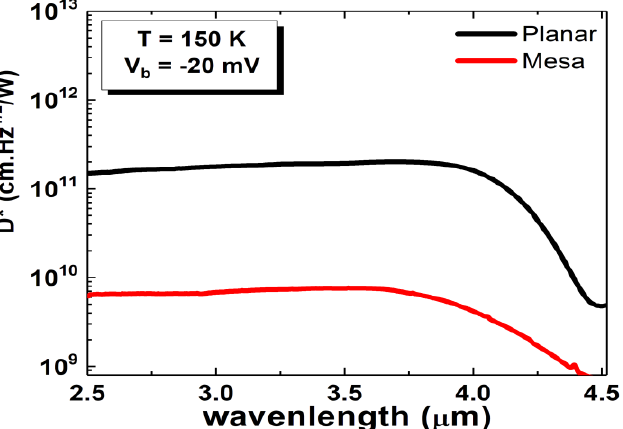
Figure 5. The comparison between the specific detectivity ( D ∗ ) spectral for the MWIR planar photodetector and mesa-isolated photodetector under − 20 mV at 77 K ( up ) and 150 K ( down ).